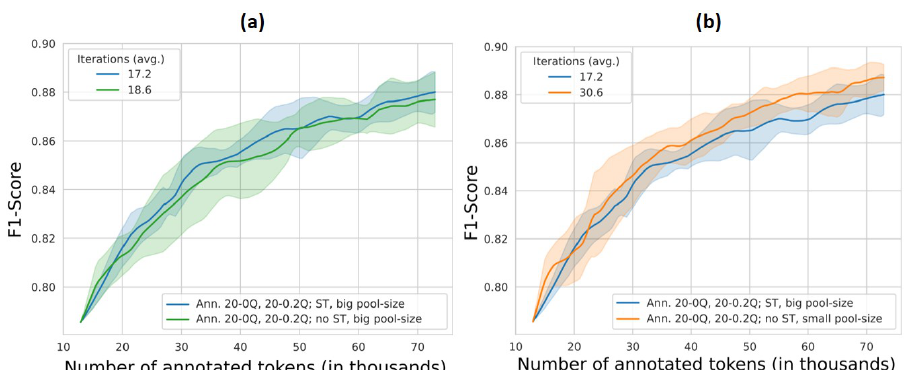
Figure 6. Influence of self-learning on model performance when a ( a ) large and ( b ) small pool size is used for